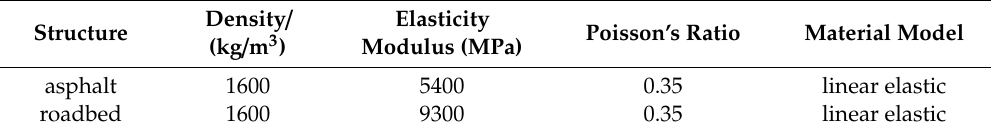
Table 1. Material properties of asphalt concrete road FE model.